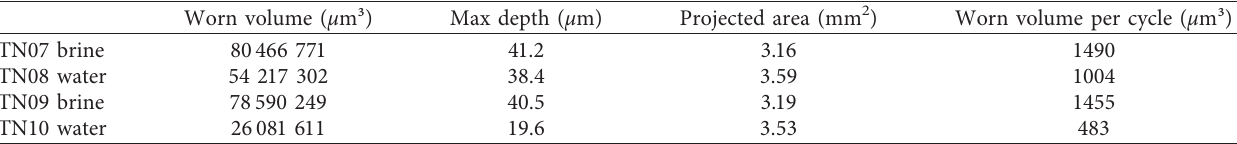
Figure 3: Friction data indicates transition to corrosive wear around time of 1800s when immersed in brine. Table 3: Wear